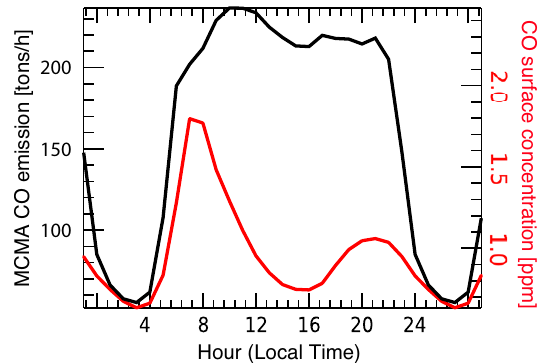
Fig. 2. The black line shows the average temporal behaviour of the CO emissions in Mexico City per hour and is taken from the offi- cial inventory of 2008 (SMA-GDF, 2010a). The red line shows the average temporal evolution of CO surface concentration averaged over the 5 nearest monitoring sites during